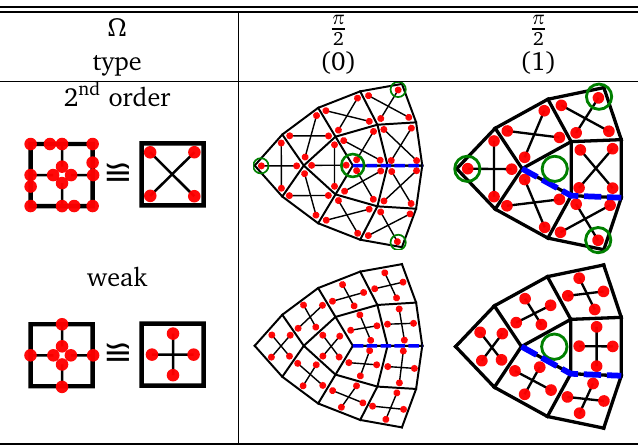
Figure 8: Decorations of fourfold-symmetric lattices with π/ 2 disclinations of both types: decorations with second-order topological phases and decorations with weak topological phases. The left column depicts the corresponding topological crystals. For simplicity, anomalous bound states hybridizing within a unit cell are not shown. We use the same symbols and colors as in Fig.